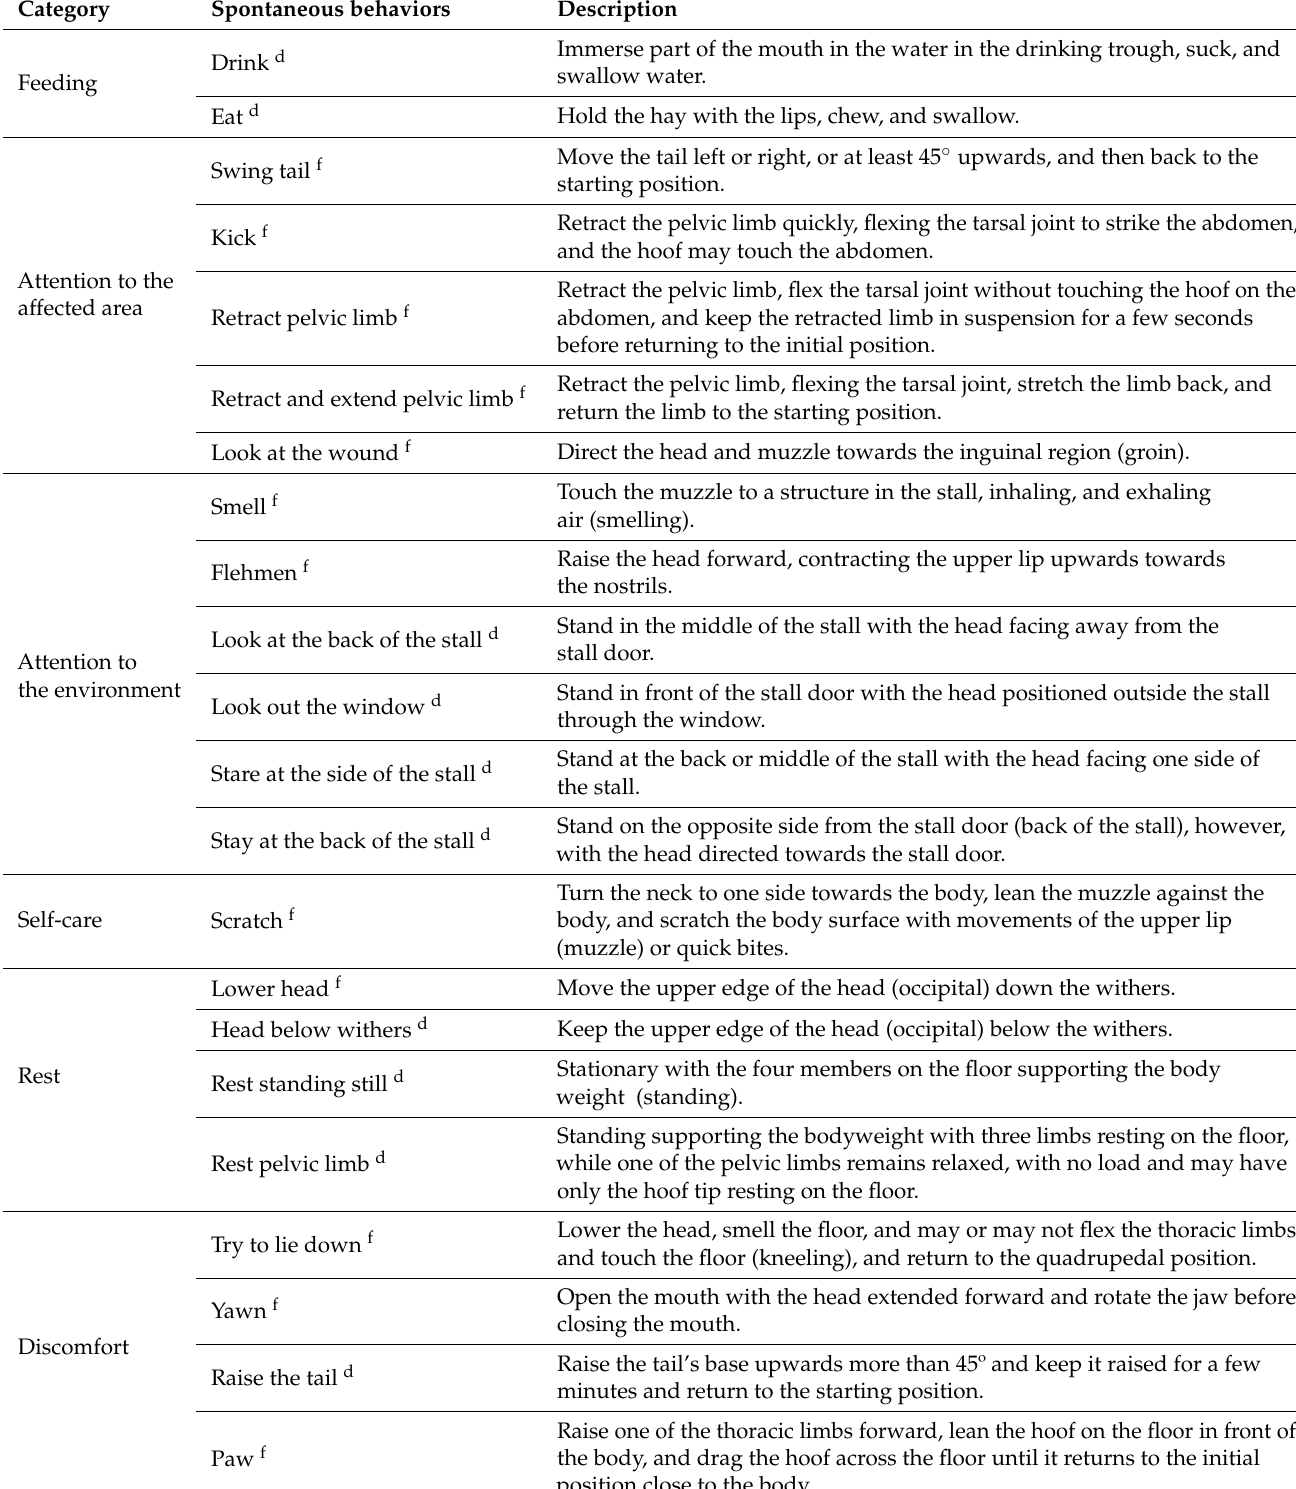
Table 1. Description and category of the recording of 34 spontaneous behaviors classified in 9 categories to compose the ethogram of 24 horses after anesthesia, analgesia, and orchiectomy ( d duration; f frequency). The behavioral categories were based on previous studies